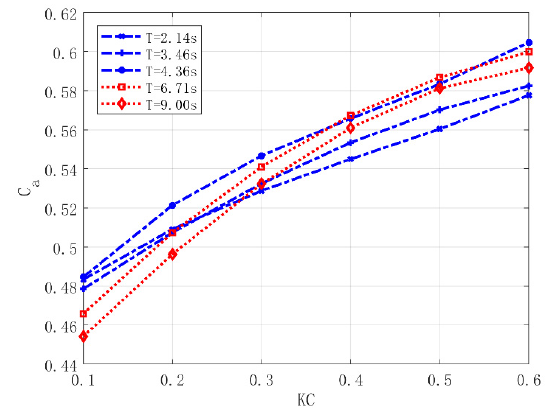
Figure 10. Added mass coefficients of the heave plate.